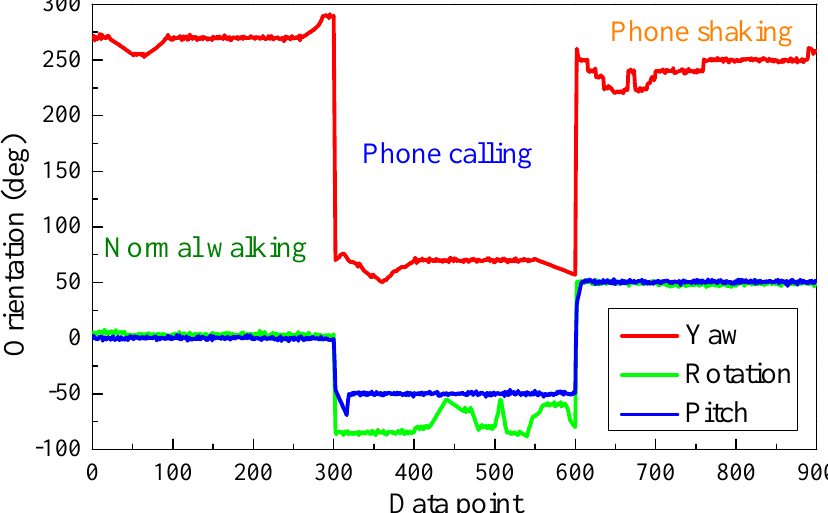
Figure 4. Acceleration of user’s activity pattern in x , y , z directions.